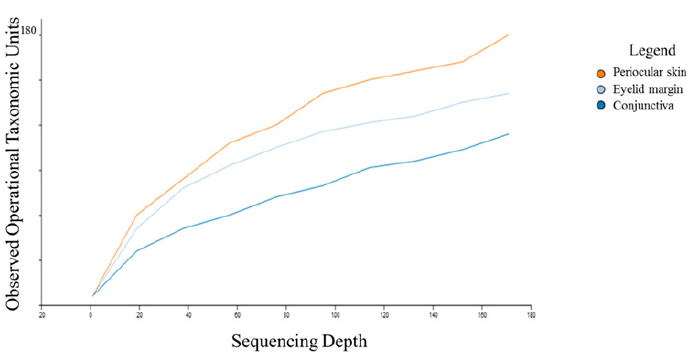
Figure 1. Number of operational taxonomic units by anatomic site.